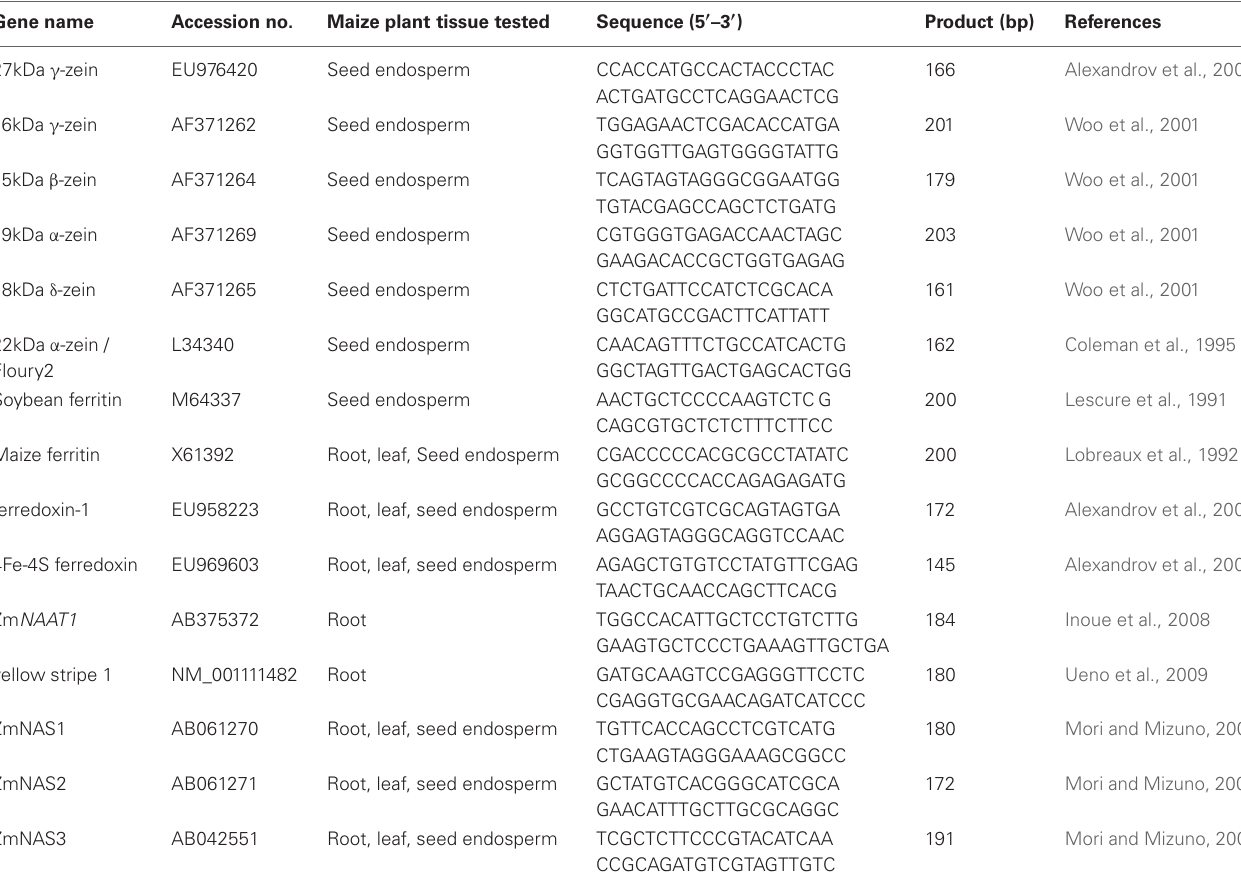
Table 1 | Details on gene, primer information, and maize plant tissue in which the gene was tested in the QPCR